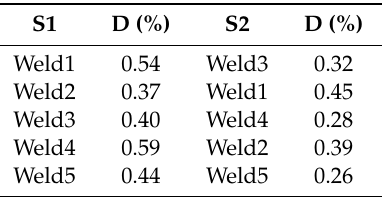
Figure 5. Results of macroscopic testing: ( a ) specimen S1, ( b ) specimen S2. Table 4. The dilution in the S1 and S2.